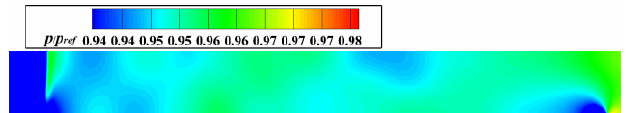
Figure 18. Pressure distribution in the passage at 0.16 ms for the case of gap width of 0.8 mm, pressure ratio of 1.5.